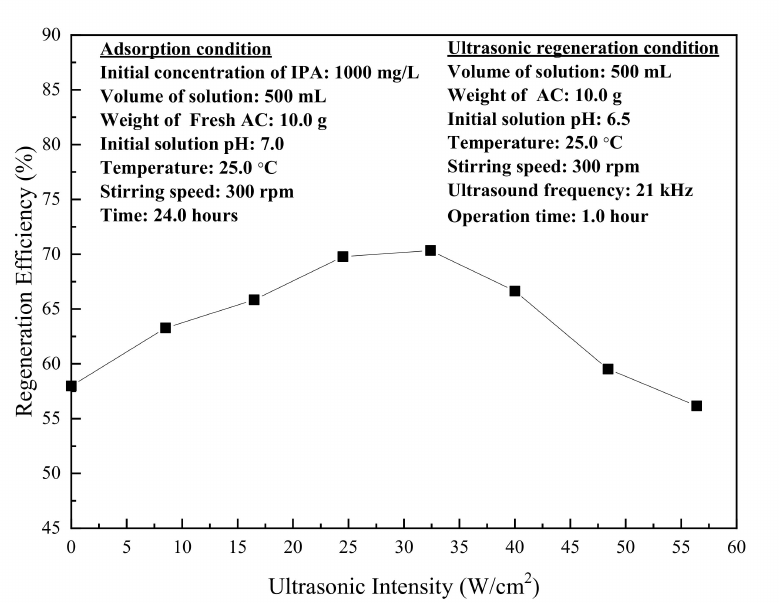
Figure 5. E ff ect of ultrasonic intensity on the regeneration e ffi ciency of exhausted activated